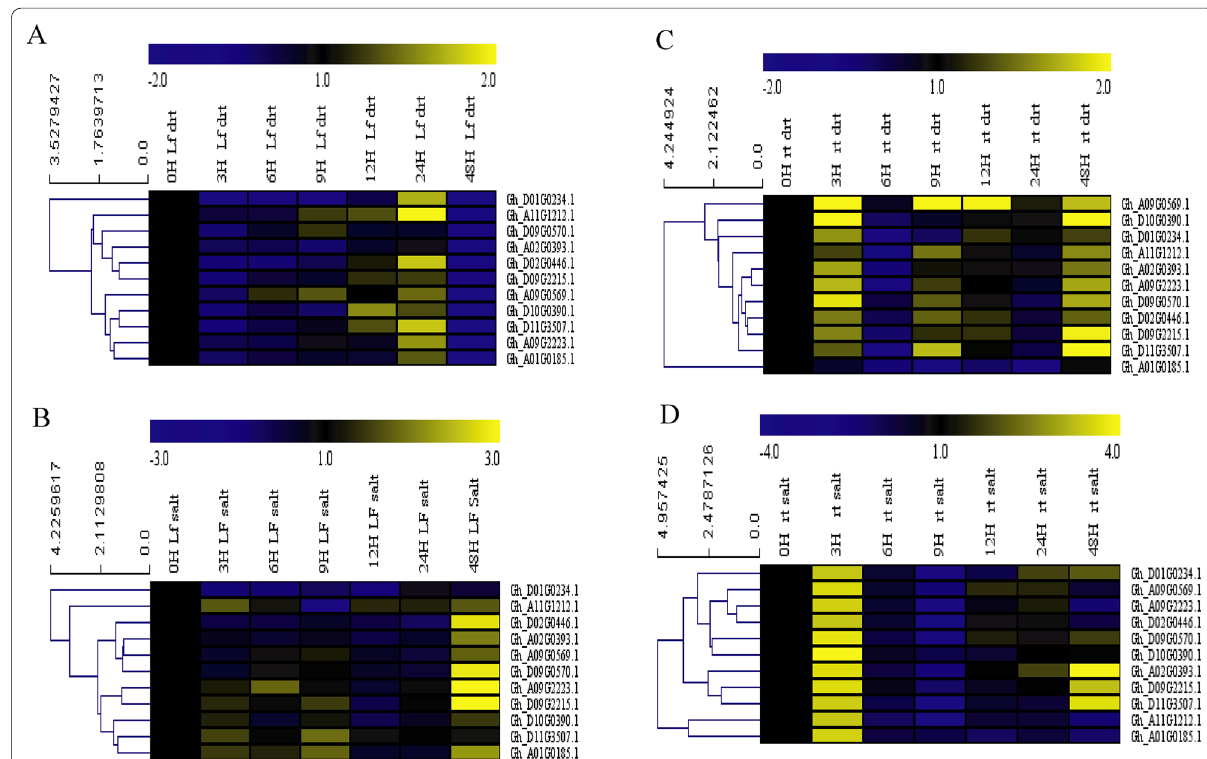
Fig. 6 Differential expression of GhRPL14B genes under drought and salt stress. A Heat map of the RPL14B gene expression in the leaf under drought stress conditions. B Heat map of the RPL14B gene expression in the leaf under salt stress condition. C Heat map of the RPL14B gene expression in the root under drought stress conditions. D Heat map of the RPL14B gene expression in the root under salt stress condition. Yellow mark depicts a high expression level of the genes, and blue mark depicts a low expression level of genes. Black mark depicts no expression of the genes at a particular time